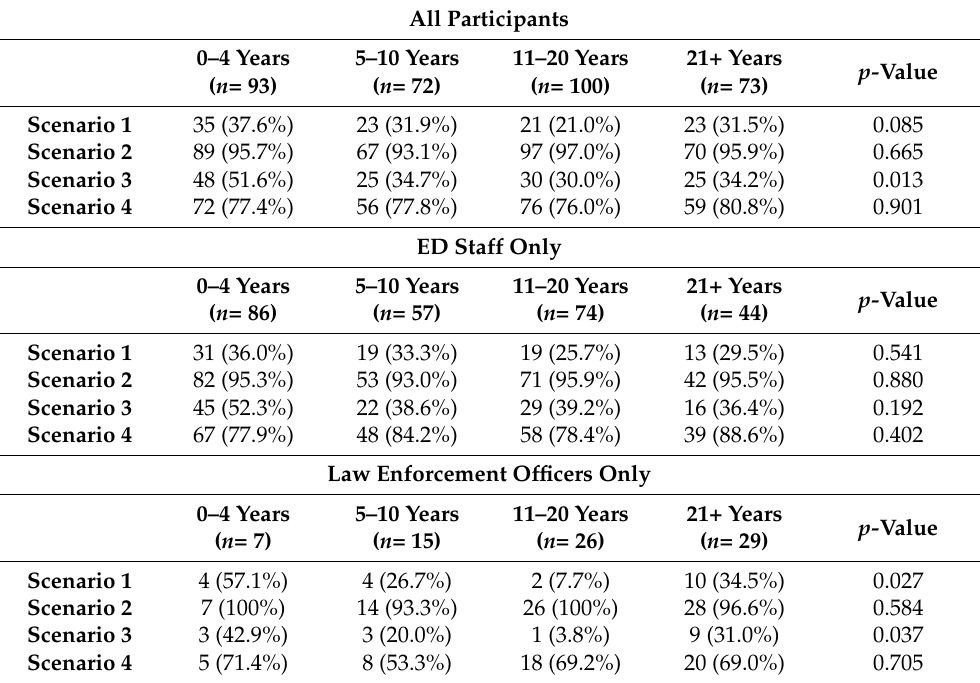
Table 4. Number (percentage) of respondents indicating the scenario demonstrated a reportable crime by years of experience.